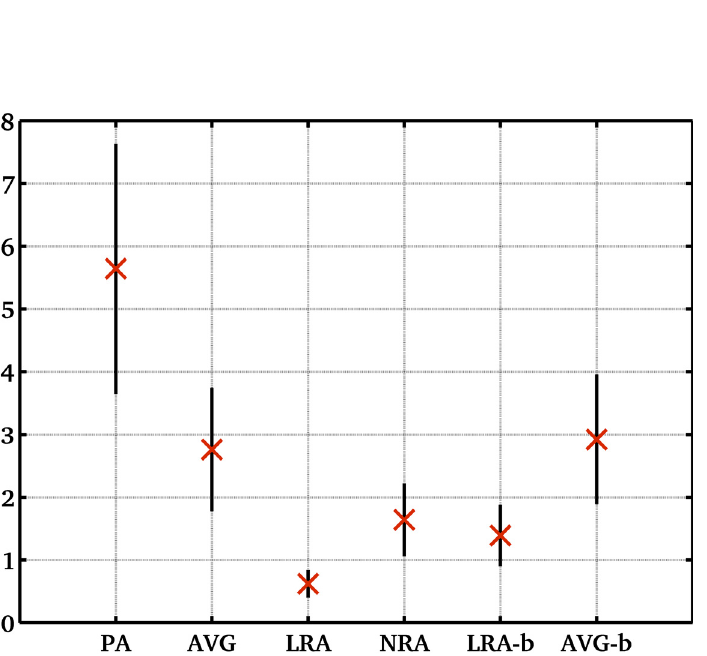
Fig 6. Mean ADC variability (%) within population for different methods. The within population average variability (based on percentage change in mean ADC figures for different volunteers and methods as given in Table 3); methods include protocol A and the corresponding average slice using protocol B with and without motion correction; error bars show accuracy of each value).